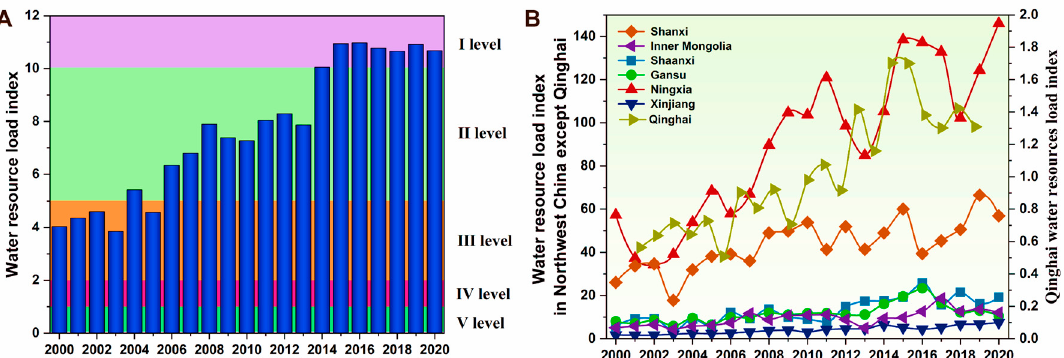
Figure 3. Dynamic changes in water-resource load index in Northwest China from 2000 to 2020. Note: ( A ) shows the variation trend of water resource load index over time in Northwest China. ( B ) shows the change trend of water resource load index over time in each province of Northwest China.